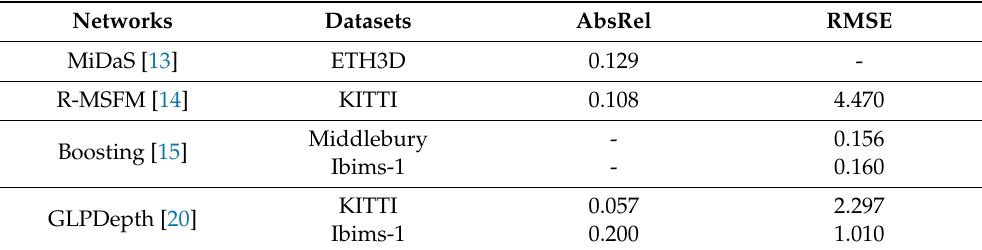
Table 1. Comparison of monocular depth map estimation networks. The metric values correspond to those reported in their respective